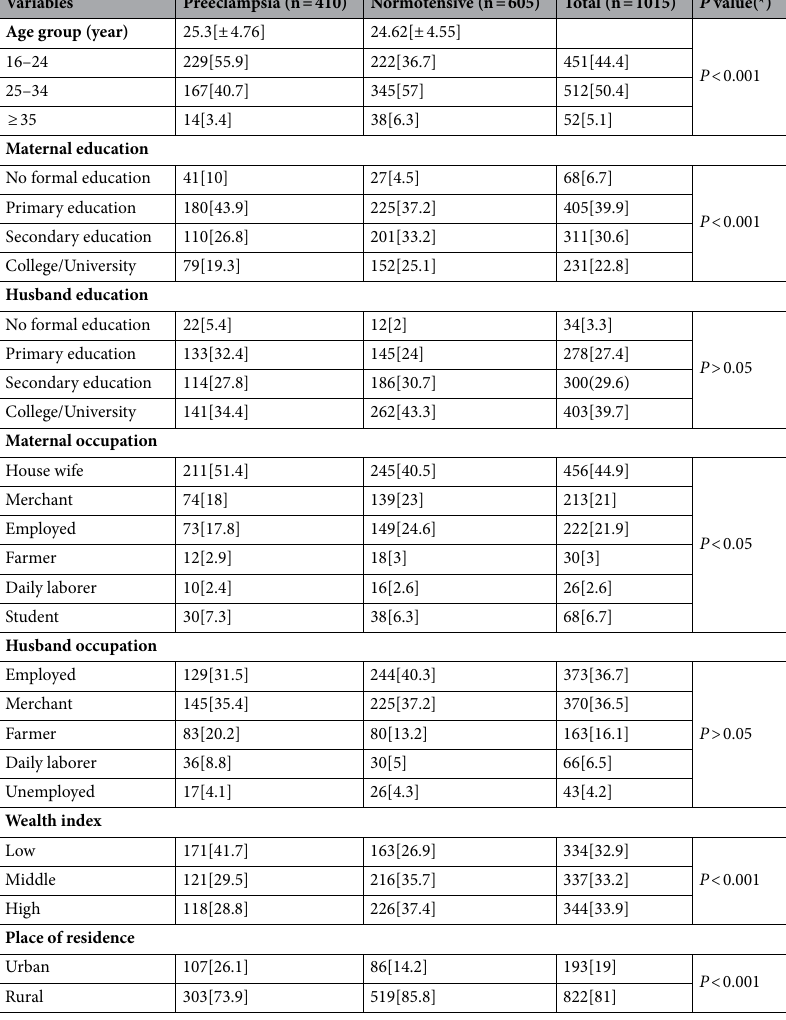
Table 1. Socio-demographic and economic characteristics of women with preeclampsia and normotensive women in Sidama region, southern Ethiopia from August 8, 2019, to October 1, 2020. * P value < 0.05 was considered statistically